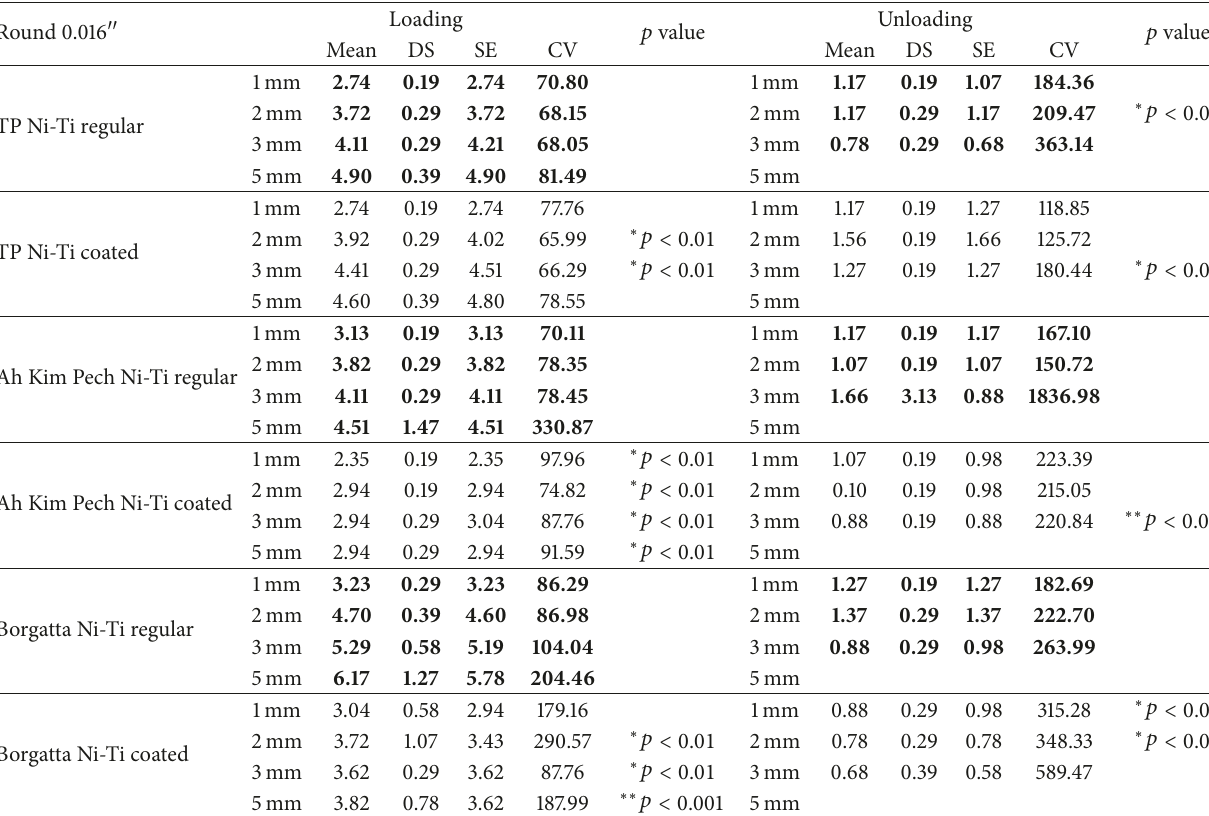
Table 1: Comparison of the mean force in Newtons between the regular and coated Ni-Ti round 0.016 󸀠󸀠 wires at different deflection loads. The results are expressed as the mean ± SEM for 15 Ni-Ti wires. ∗ 𝑝 < 0.01 and ∗∗ 𝑝 < 0.001 , experimental group significantly less than control. Round 0.016